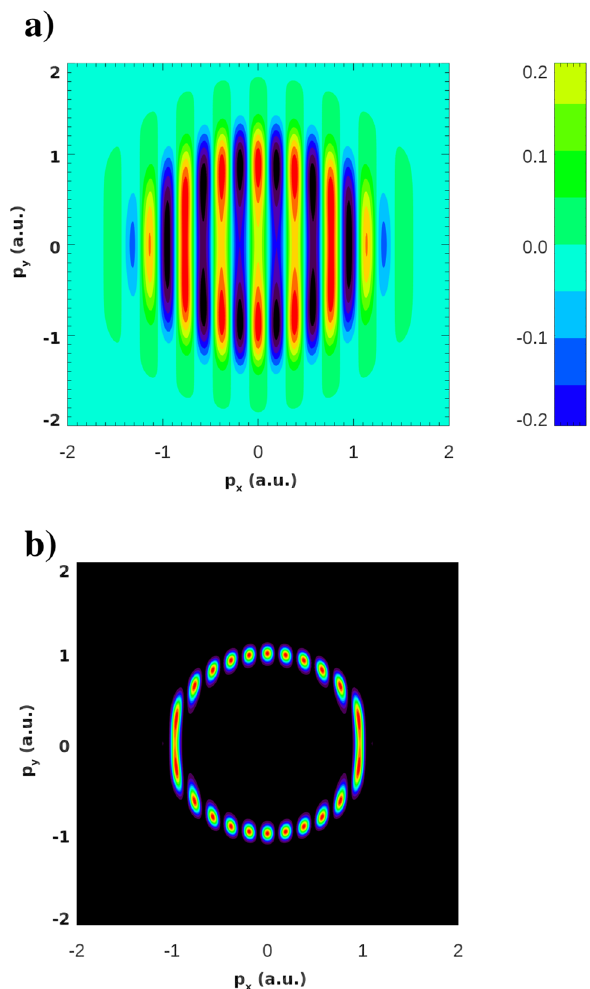
Figure 5. ( a ) The Fourier transform of the wave-function (atomic units are used) and ( b ) the corresponding PMD for the frequency of the probe pulse (cid:31) hydrogen atoms in the ground 1 s state placed at the distance R